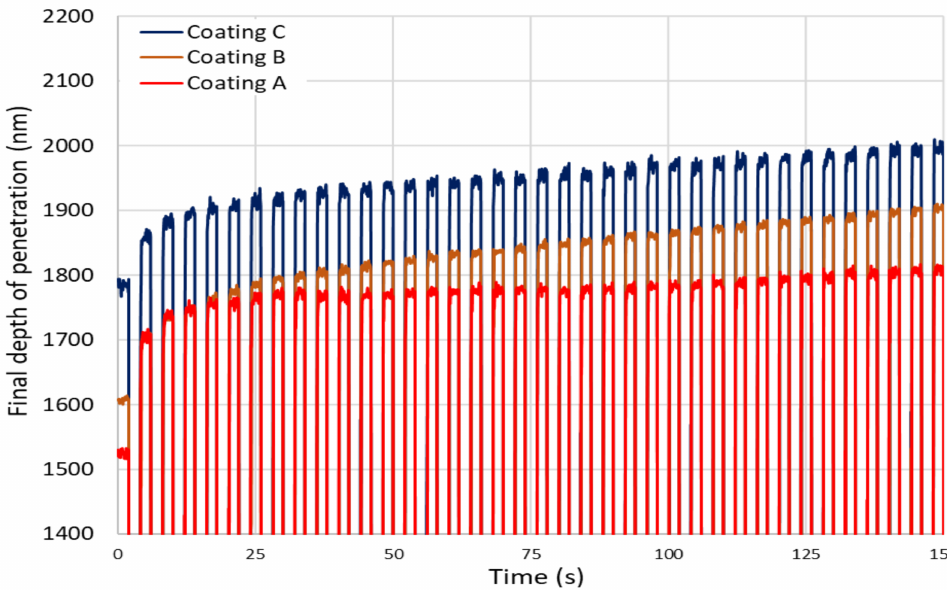
Figure 15. First 150 s depth of penetration obtained from nano-impact testing at a load of 20 mN for the TiB 2 coatings.